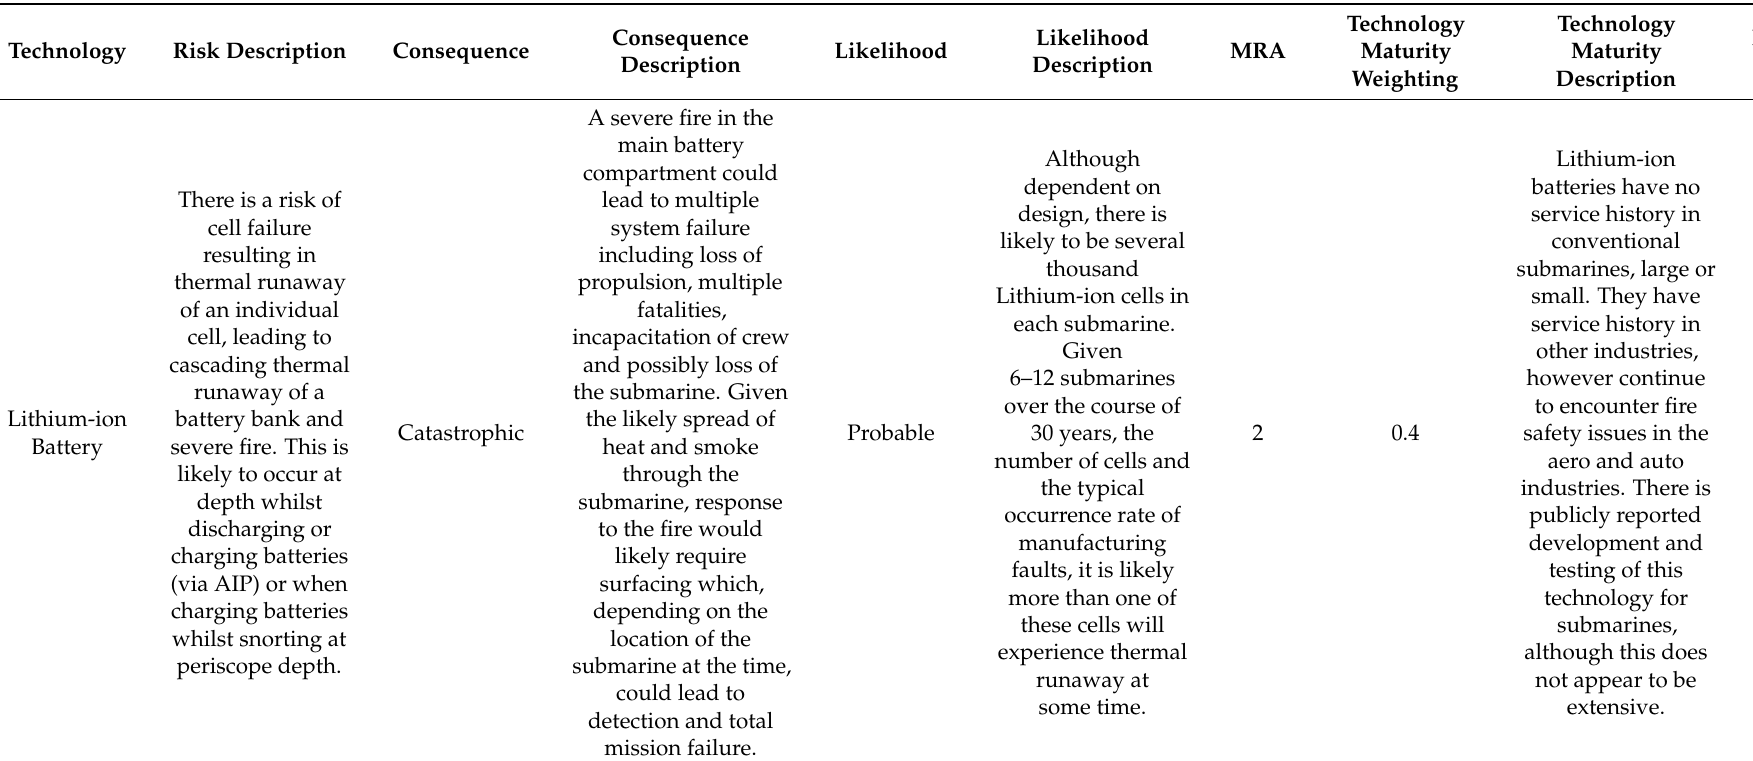
Table 10. Fire Safety of Critical Technologies—Semi-quantitative Risk